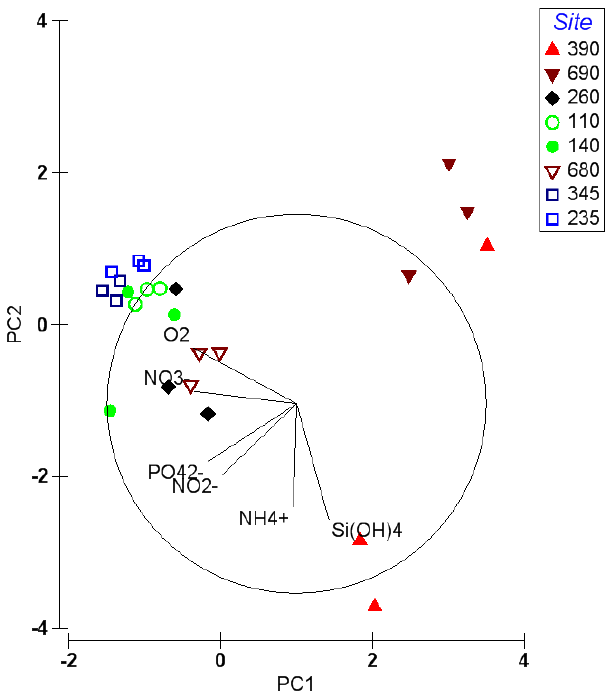
Fig. 3. Principal component analysis (PCA) plot showing the non- metric multivariate similarity among replicate samples in terms of benthic boundary fluxes. Vectors indicate the direction and strength of each flux’s contribution to the overall distribution (Table 3). Brown and red triangles: shallow Mackenzie Shelf and Delta; green circles: Cape Bathurst and Amundsen Gulf region (east); blue squares: deeper Mackenzie Slope.